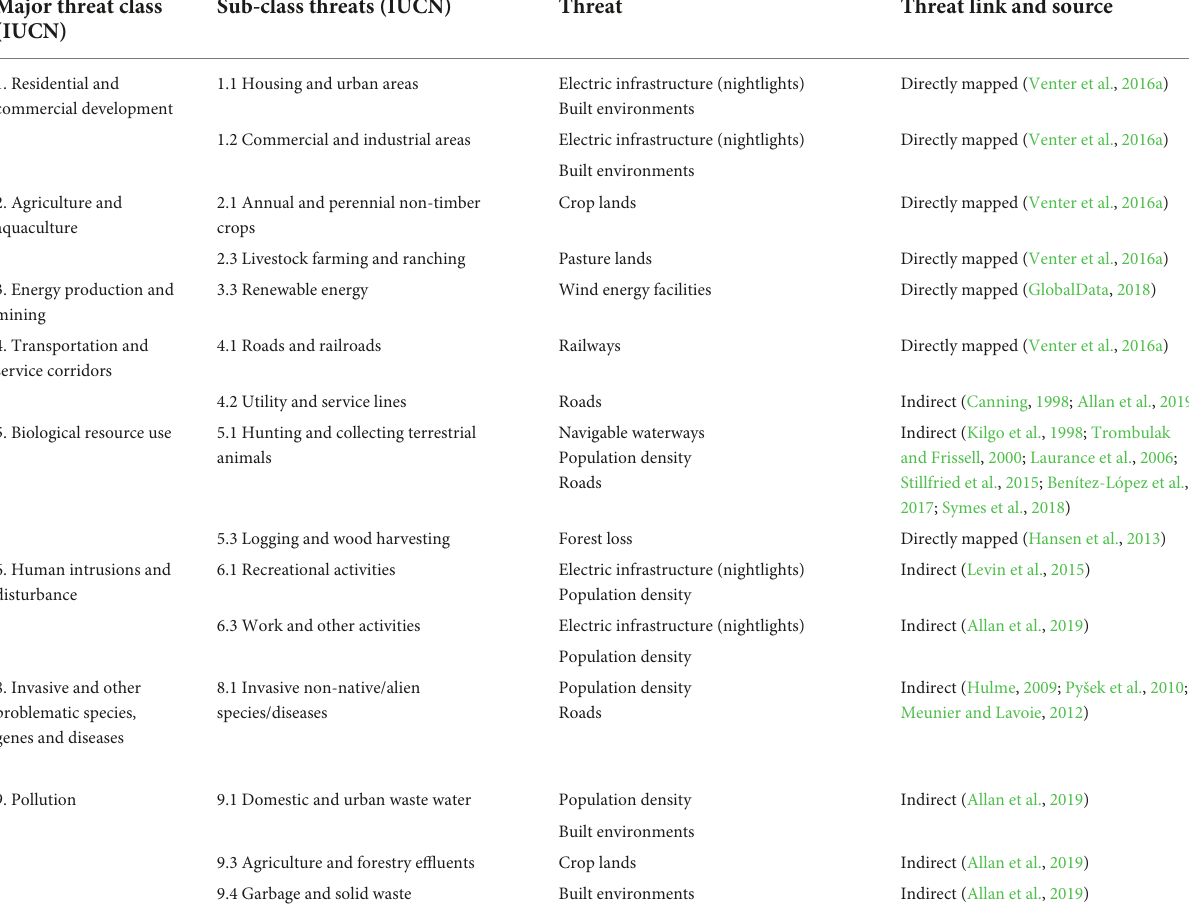
TABLE 2 Major classes and sub-classes of threats to biodiversity as classified in the IUCN Red List of Threatened Species (IUCN, 2022), and the corresponding spatially explicit threat variable from the updated Human Footprint, GlobalData, and Global Forest Change (Hansen et al., 2013; Venter et al., 2016a; GlobalData,